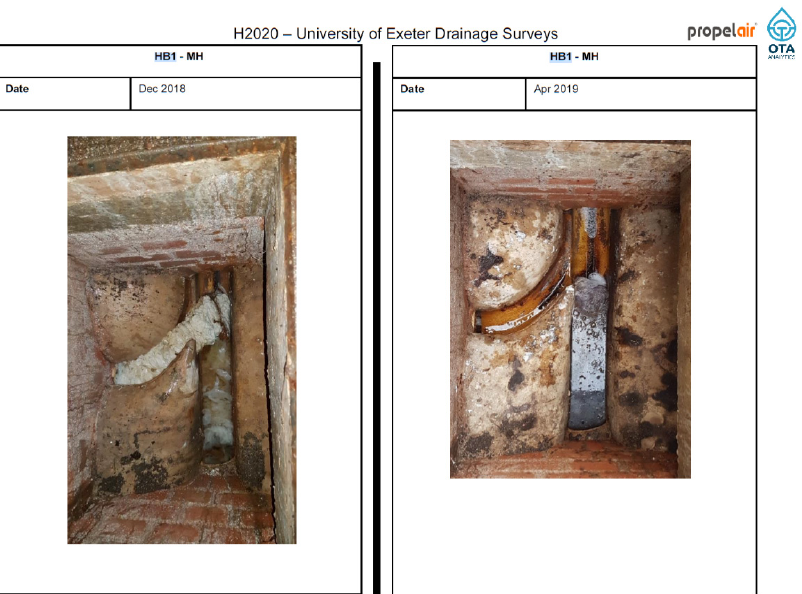
Figure 6. Photograph of Manhole HB 1 from lift and look surveys in December 2018 and April 2019. The image on the left- hand side shows a blockage in the chamber caused by a build-up of rag.